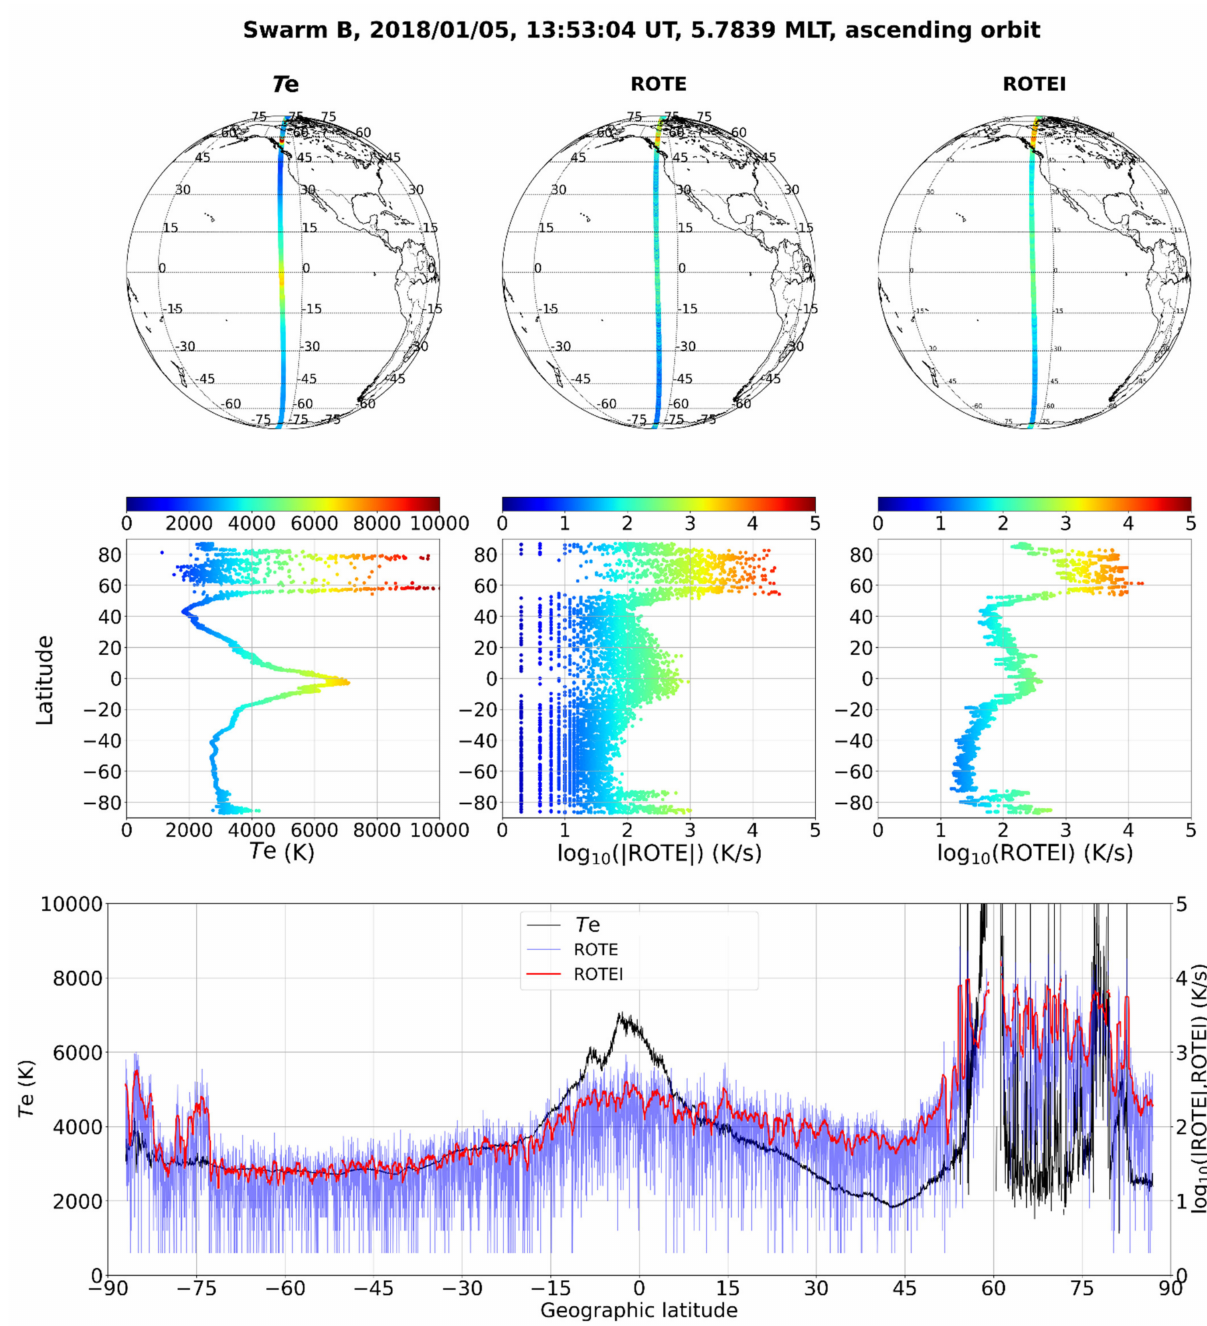
Figure 1. T e (first column), ROTE (second column), and ROTEI (third column) values recorded by Swarm B on 5 January 2018 at 13:53:04 UT (equator crossing point), ascending semiorbit. Data are represented in geographic maps (first row plots), and as separated (second row plots) and superposed time series (third row plots). In the first and second row plots, data are represented as scatter points whose color identifies the corresponding magnitude (ROTE and ROTEI values are in logarithmic scale). In the bottom plot, data are represented as curves of different colors: black for T e, blue for ROTE, and red for